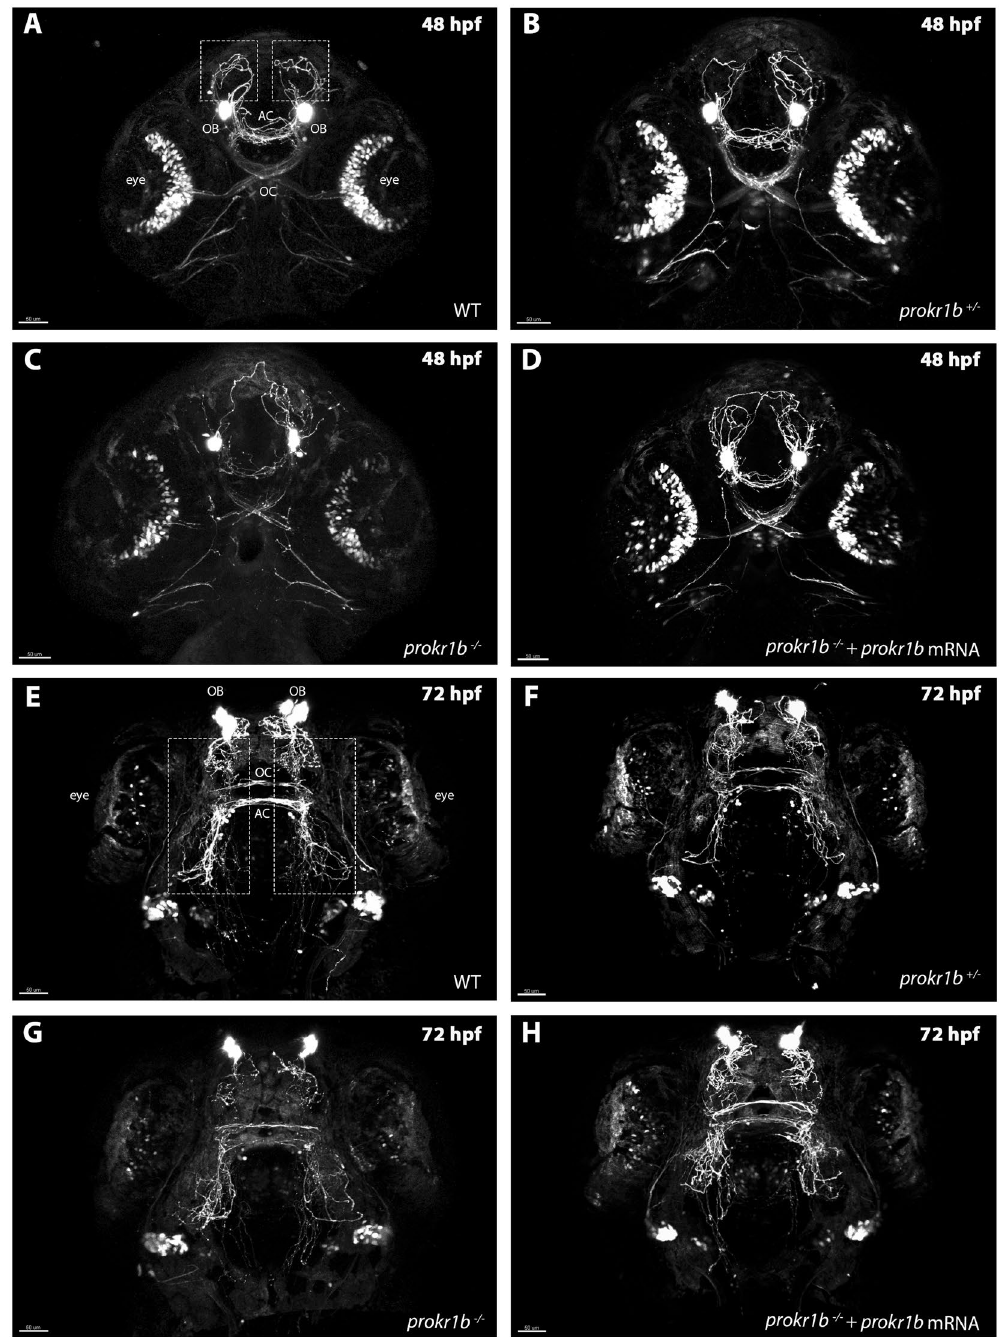
Figure 4. prokr1b homozygous mutant zebrafish ( tg(gnrh3:EGFP);prokr1b − / − ( C,G ) exhibit misrouting of rostral (dotted square) and optic chiasm (OC) fibers. These defects are not present in WT ( A,E ) and prokr1b heterozygous mutants ( tg(gnrh3:EGFP);prokr1b + /- ( B,F ). The prokr1b mutant phenotype is rescued by injection with WT prokr1b mRNA ( D,H ). OB = olfactory bulbs, OC = optic chiasm, AC = anterior commissure. Scale bar = 50 µ